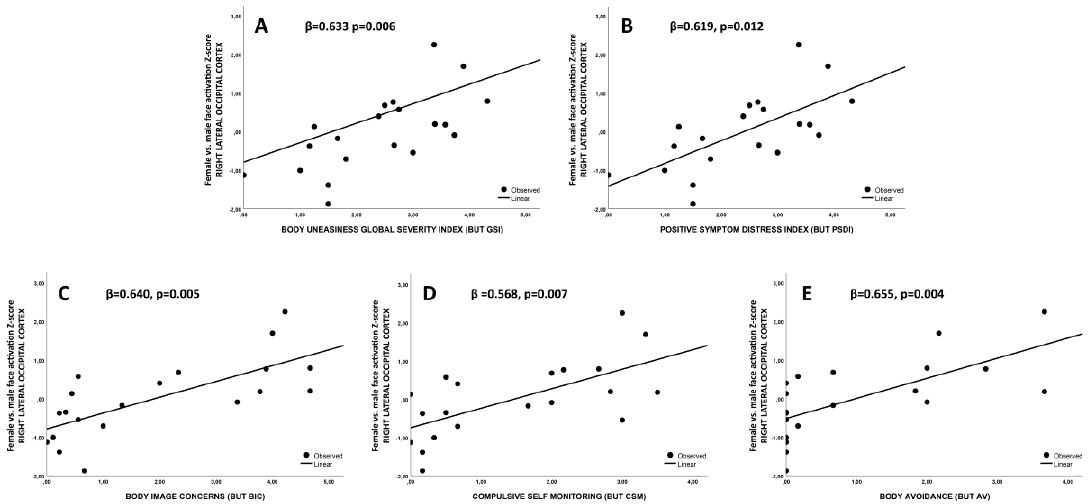
Figure 7. ( A )–( E ) Association between right lateral occipital cortex Z-score and body uneasiness test related scales.